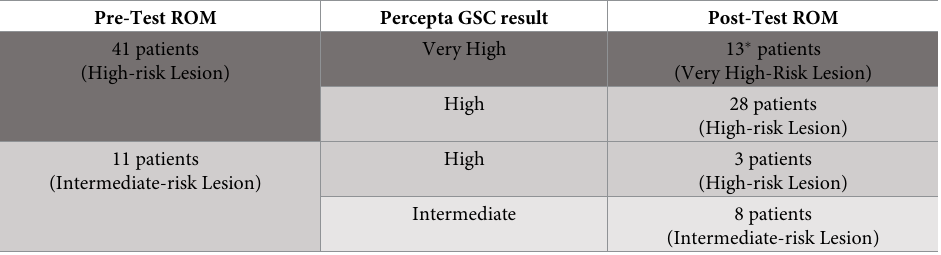
� Patients from the AEGIS cohorts only; ROM, risk of malignancy; � Unable to verify procedures performed for one